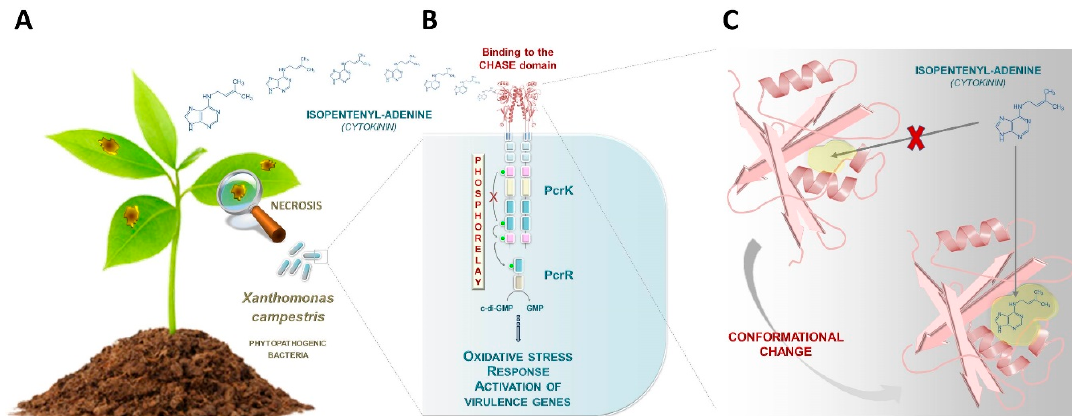
Figure 1. Towards the identification of a cytokinin (CK) signaling pathway in bacteria. ( A ) The gram-negative bacterium, Xanthomonas campestris , is the causative agent of black rot disease in crucifers. ( B ) Wang and colleagues have recently described a bacterial receptor (PcrK) that is capable of perceiving plant-borne isopentenyladenine in this plant pathogenic species [16]. When this plant hormone binds to the bacterial PcrK, the autokinase activity of PcrK is inactivated, leading to dephosphorylation of the response regulator PcrR. The phosphodiesterase activity of PcrR (active when dephosphorylated) leads to the expression of many genes, including those involved in the resistance to oxidative stress, thus enhancing bacterial resistance to host defenses. ( C ) Chen and colleagues determined the crystal structure of the cyclase/histidine kinase associated sensor extracellular (CHASE) domain of the PcrK receptor [17]. The ligand binding pocket of the PcrK CHASE domain was captured in a “closed” conformation that presumably undergoes a conformational change to reach the “open” state, which is capable of isopentenyladenine binding. These conformational changes are thought to be mediated by a periplasmic molecule which remains unidentified.